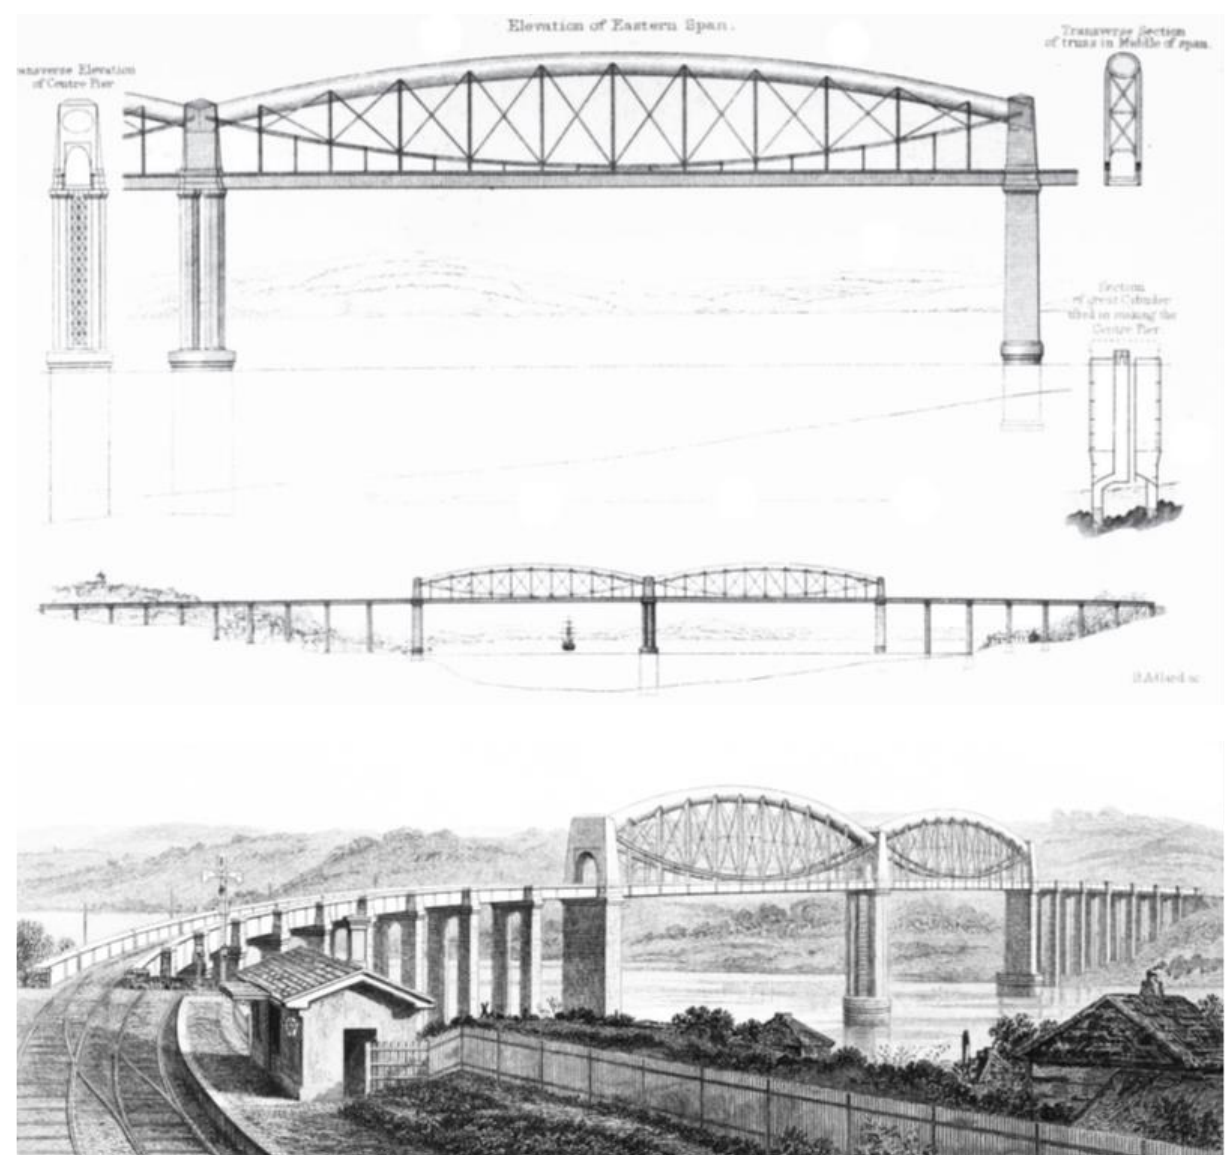
Figure 24. Royal Albert Bridge. Elevation and detail of one of the longest span structures and general view of the bridge designed by Isambard Kingdom Brunel, England, 1854. Source: “The life of Is- ambard Kingdom B runel, civil engineer”. by Isambard Brunel, B.C.L., of Lincoln’s Inn; chanc ellor of the diocese of Ely, London: Longmans, Green, and Co., 1870.